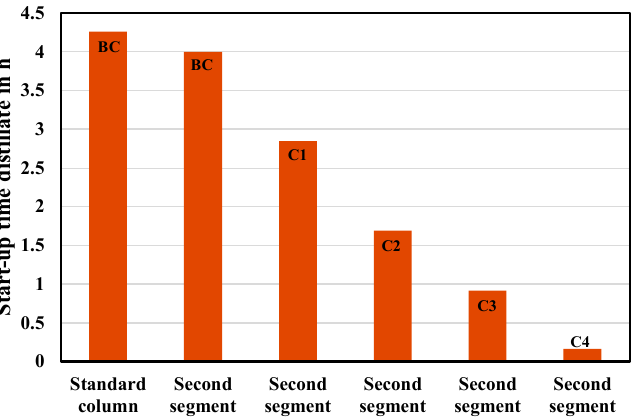
Figure 10. Comparison of absolute start-up times of the distillate for the activation of an additional distillation column with standard geometry and an additional segment of the segmented distillation column.